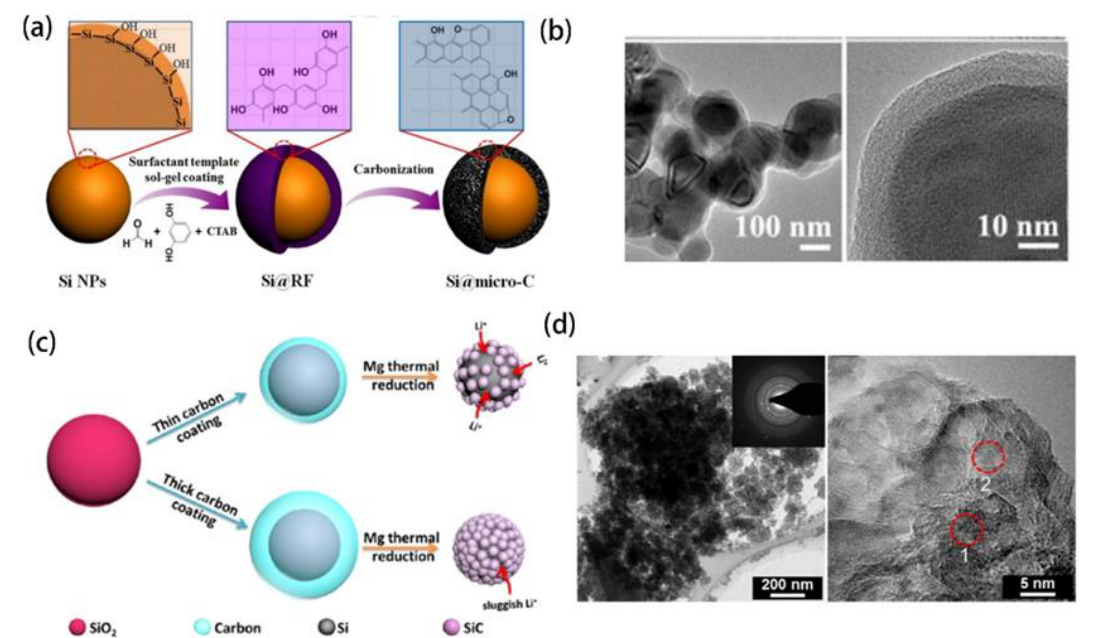
Figure 13. ( a ) Schematic illustration and ( b ) TEM images of the fabrication of phenolic resin-based carbon interfacial layer coated commercial silicon nanoparticles through the surfactant template sol-gel approach [104]. ( c ) Schematic of the synthesis and ( d ) TEM images of Si@SiC derived from SiO 2 @C precursors [116]. Reprinted with permission from [104]. Copyright 2016 Elsevier. Reprinted with permission from [116]. Copyright 2017 American Chemical Society.